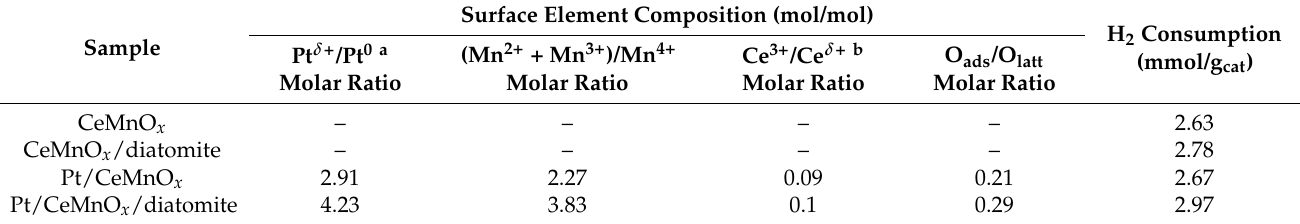
Table 2. Surface element compositions and hydrogen consumption of the CeMnO x , CeMnO x /diatomite, Pt/CeMnO x , and Pt/CeMnO x /diatomite